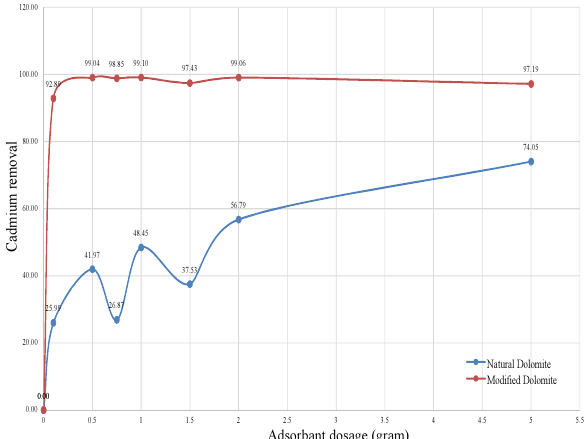
Fig. 6. Comparison of removal rate of cadmium from natural dolomite (5 mg/l) and modified dolomite with contact time of 15 minutes in specified adsorbents